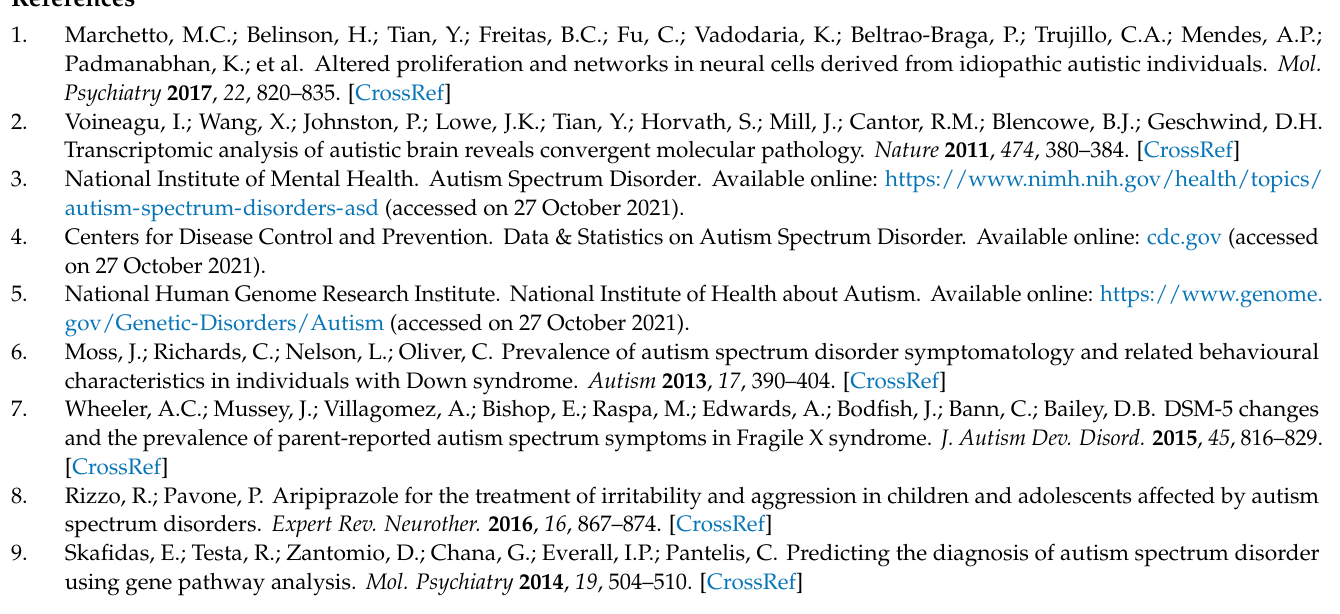
and ASD in the neural cells. The color refers to the log2(size of a regulatory cascade), and the dark red represents the regulatory cascade lost in ASD. Figure S5: (A) GATA1 binds to the promoter regions of the two isoforms of the lncRNA ELF3-AS1. The promoter region of the lncRNA was defined as